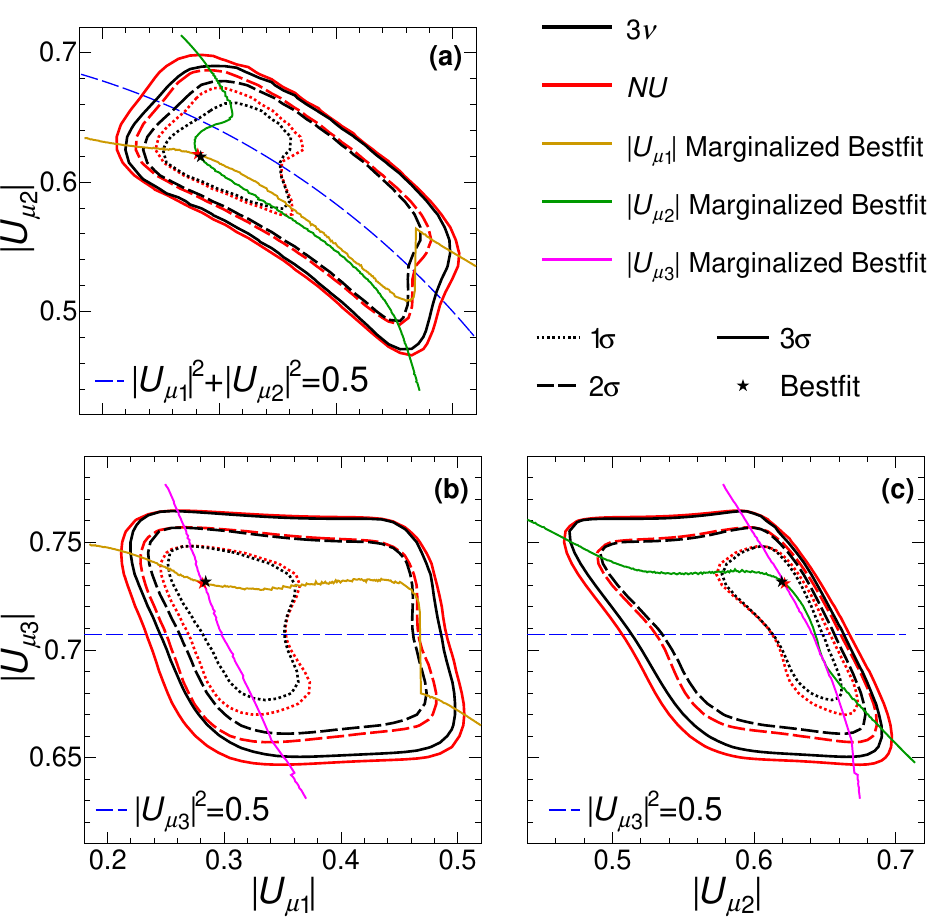
Figure 2 . The 2-D ∆ χ 2 contours in ν µ sector. Allowed regions at 1 σ (dotted), 2 σ (dashed), 3 σ (solid) confidence levels are shown, on (a) the | U µ 1 | − | U µ 2 | plane, (b) the | U µ 1 | − | U µ 3 | plane, and (c) the | U µ 2 | − | U µ 3 | plane. Also shown are the best-fits of | U µ 1 | (orange), | U µ 2 | (cyan), and | U µ 3 | (magenta), minimized over all of the other parameters, projecting on the 2-D planes. Auxiliary lines (blue dashed) are drawn to help understanding the behaviours of the best-fits. | U | = 0 . 689(∆ χ 2 = 0 . 84) , and is consistent with | U µ 3